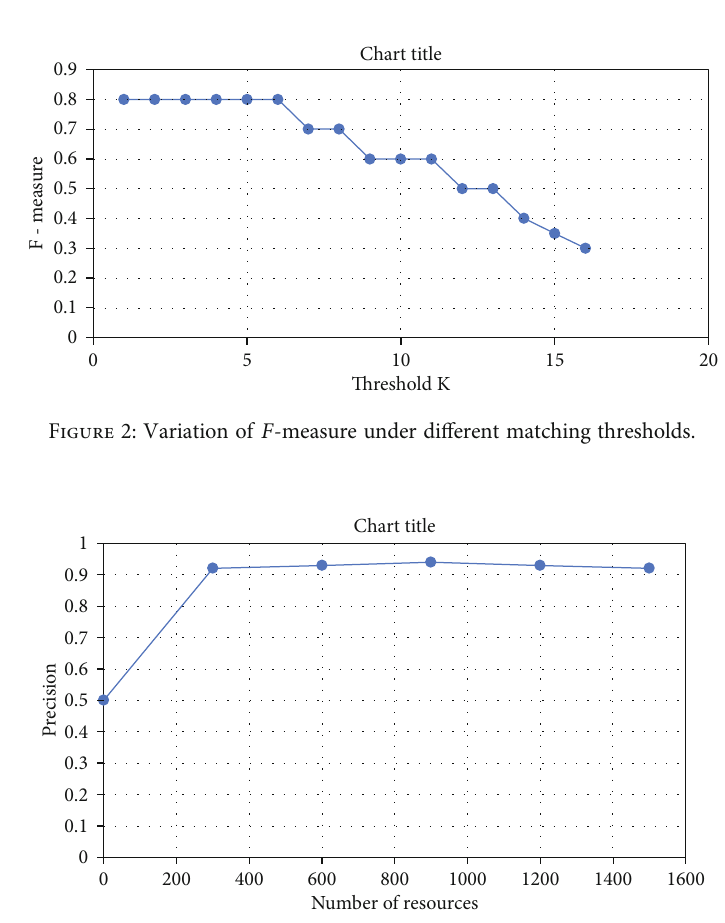
Figure 3: Similarity matching